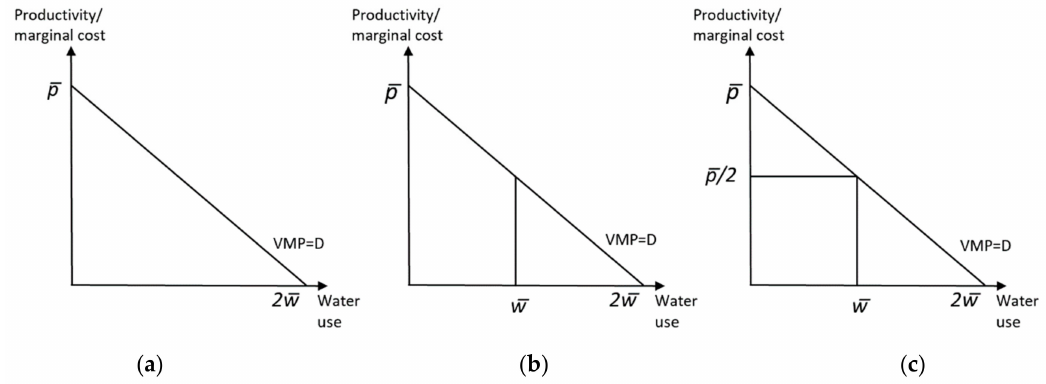
Figure 4. Water productivity in expansionary ( a ) and mature ( b , c ) water economies. VMP stands for value of the marginal product, and D is water